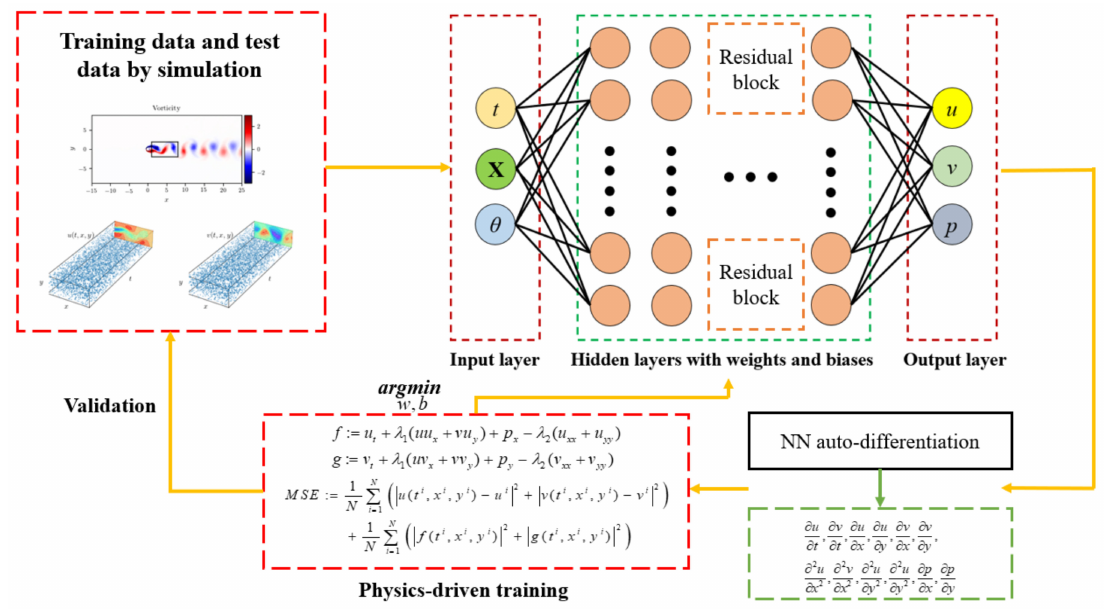
Figure 1. A schematic diagram of the physical informed neural network for solving the model of the fluid